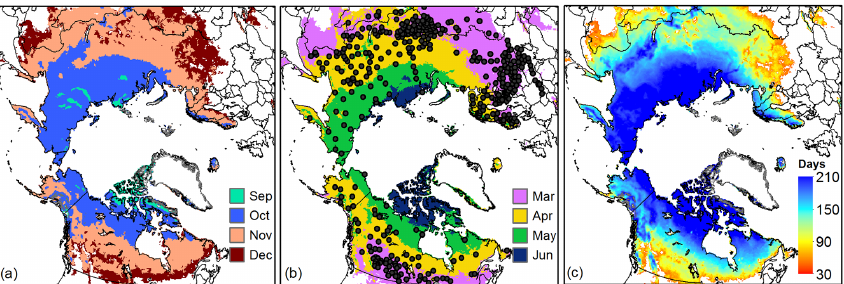
Figure 5. The mean main snow onset date in fall (a) , main melt onset date in spring (b) , and mean winter period duration (days) (c) during the period 1988–2013. The black dots in (b) represent WMO weather stations used for algorithm development and evaluation.